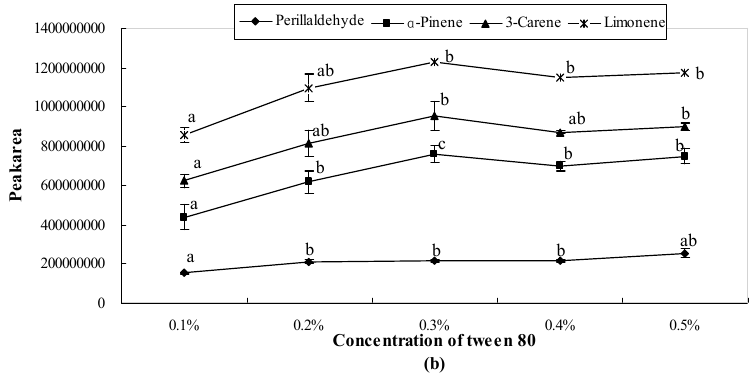
Figure 1. Effects of Tween 80 on the release of ethyl acetate, ( E )-2-hexenal, carvone ( a ) and perillaldehyde, α -pinene, 3-carene, limonene ( b ). Significant differences ( p < 0.05) between different concentrations are performed by letters on the same polylines. Where the letters on the same polyline are the same, there is no significant difference between different concentrations. The concentration gradients (0.1%, 0.2%, 0.3%, 0.4%, and 0.5%) of soybean lecithin and sucrose fatty acid ester obviously affected the release of these seven aroma compounds. ANOVA revealed a